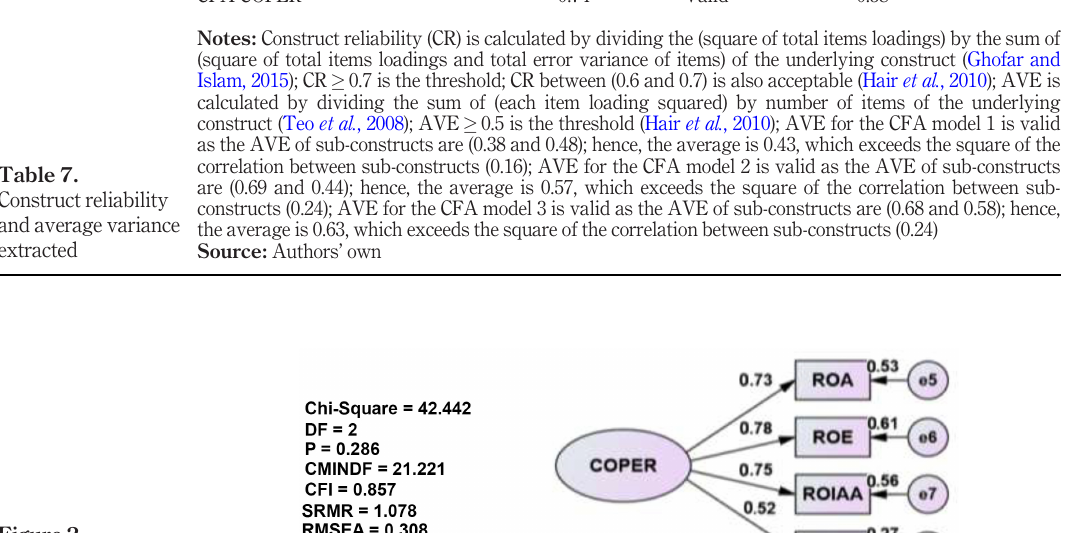
Figure 2. SFC model of COPER – Model